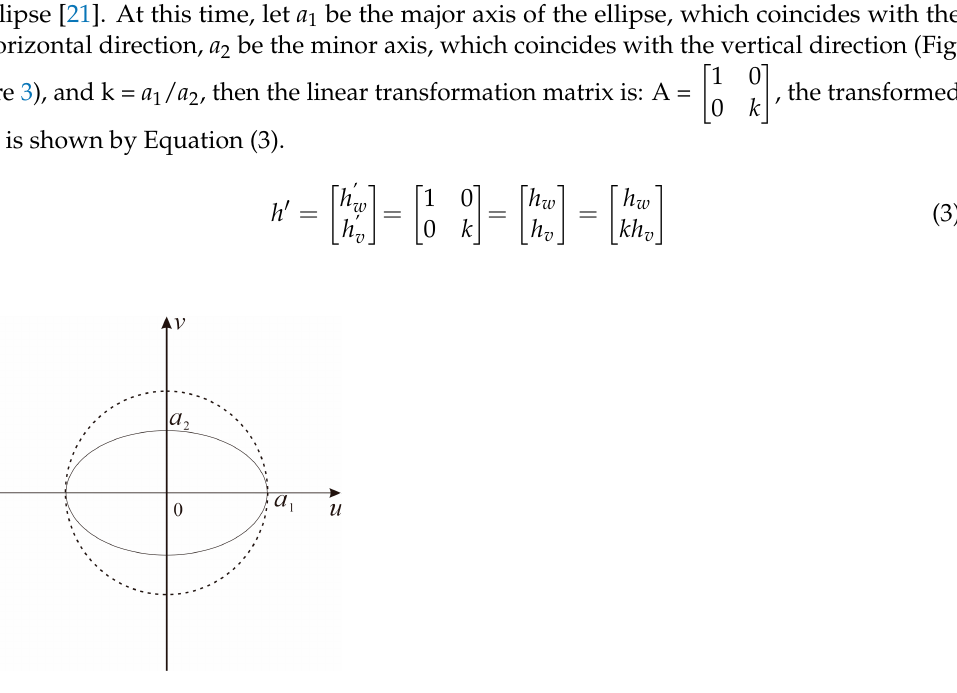
Table 1. Descriptive statistical analysis of soil salinity.